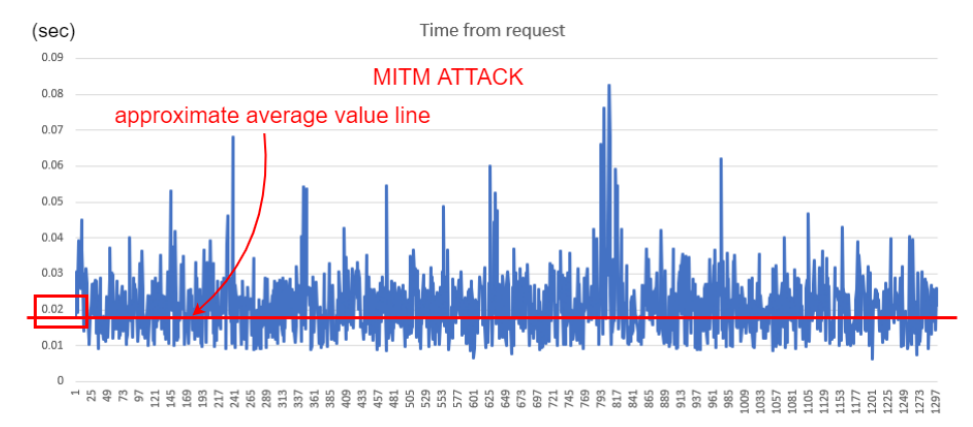
Figure 30. TFR comparison—MITM.